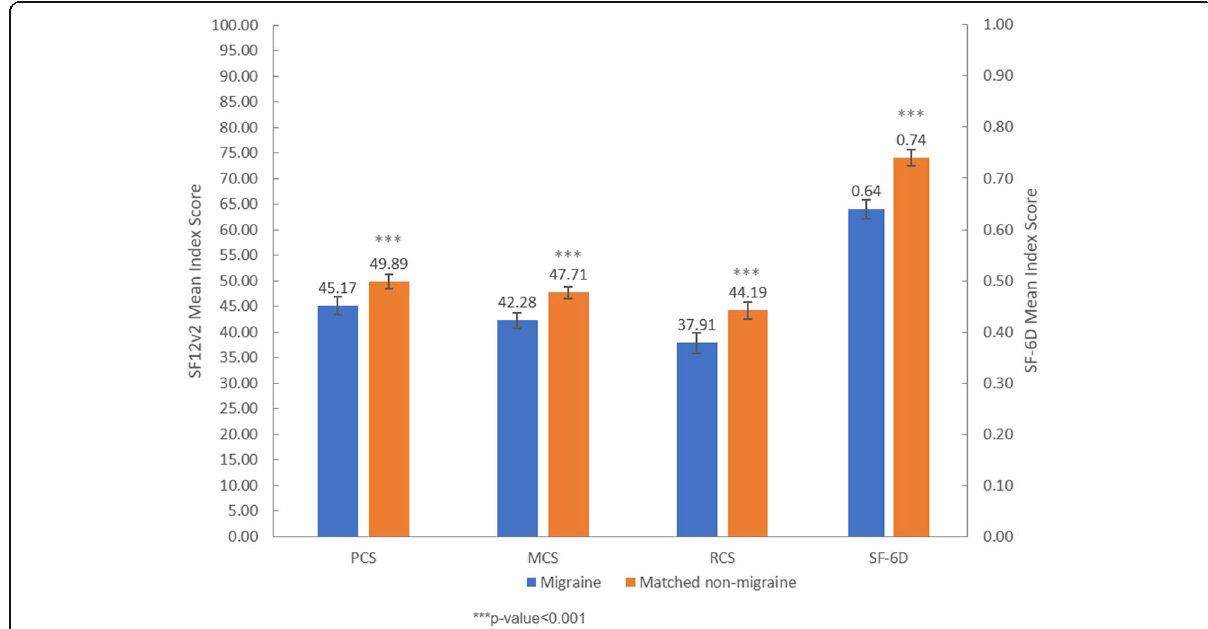
Fig. 1 Adjusted means of PCS, MCS, RCS and SF-6D scores for migraine patients and matched non-migraine respondents of the Japan National Health and Wellness Survey 2017. Adjustment for following covariates: age, gender, CCI, marital status, education, household income, region, insurance type, employment status, BMI, smoking status, alcohol use and exercise behavior. Abbreviations: PCS=physical component summary score, MCS=mental